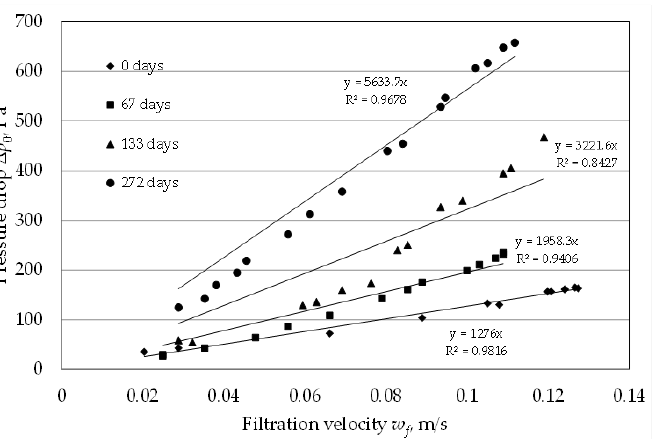
Figure 6. Pressure drop across clean filter media from the line of drilling centers.